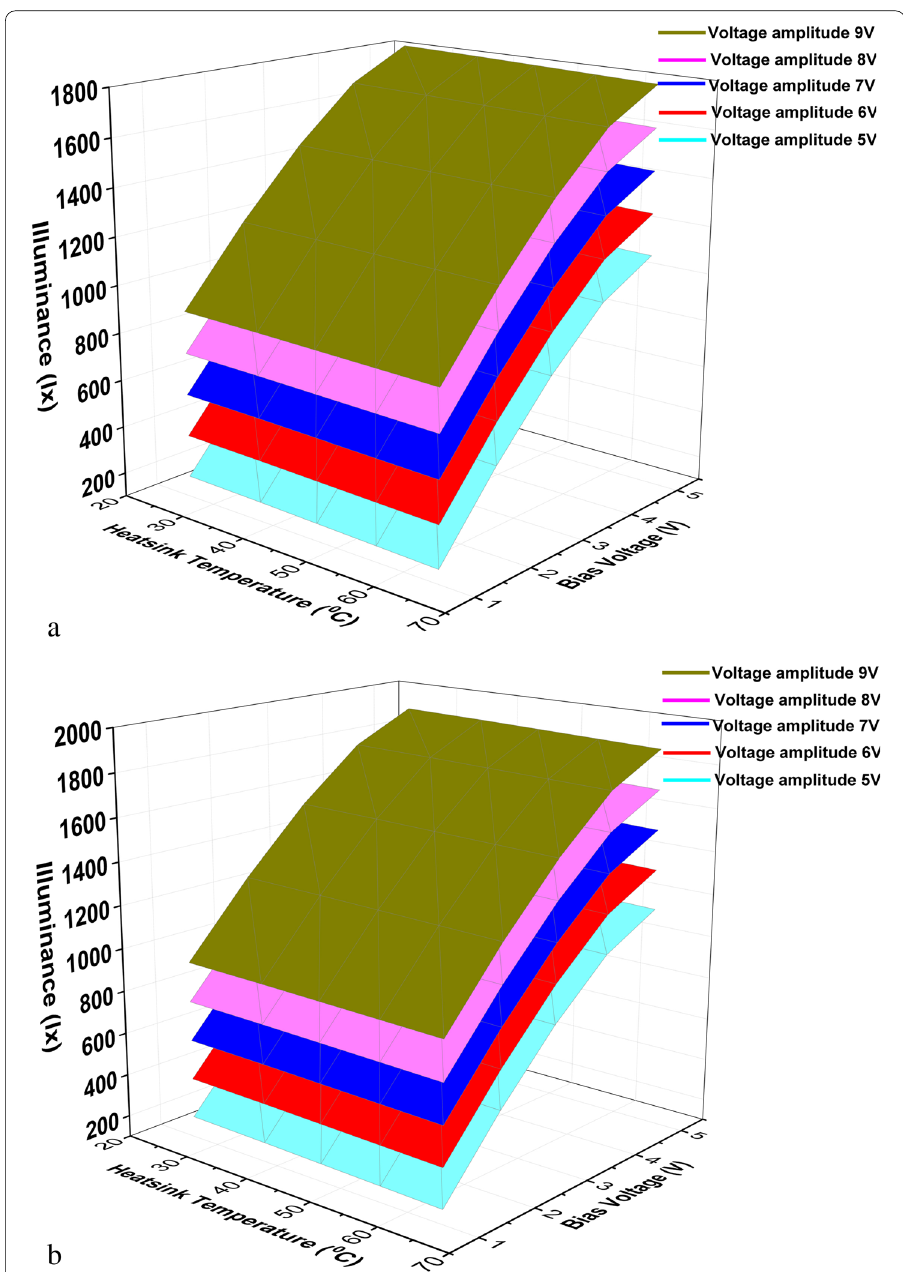
Fig. 9 a Calculated illuminance of the mixed white LED source with heatsink temperature, bias voltage, and voltage amplitude. b Measured illuminance of the mixed white LED source with heatsink temperature, bias voltage, and voltage